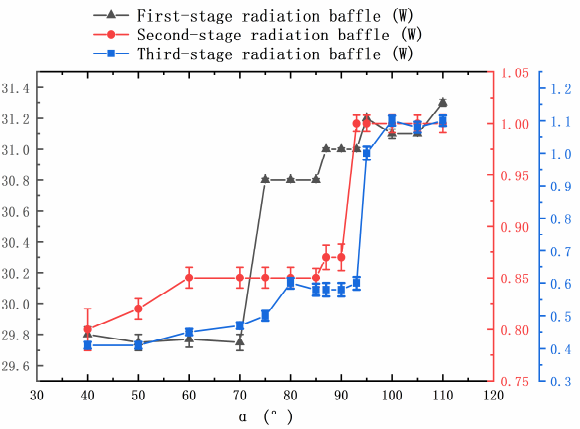
Figure 15. The structure of the cryosorption pump’s module versus α = 32°.